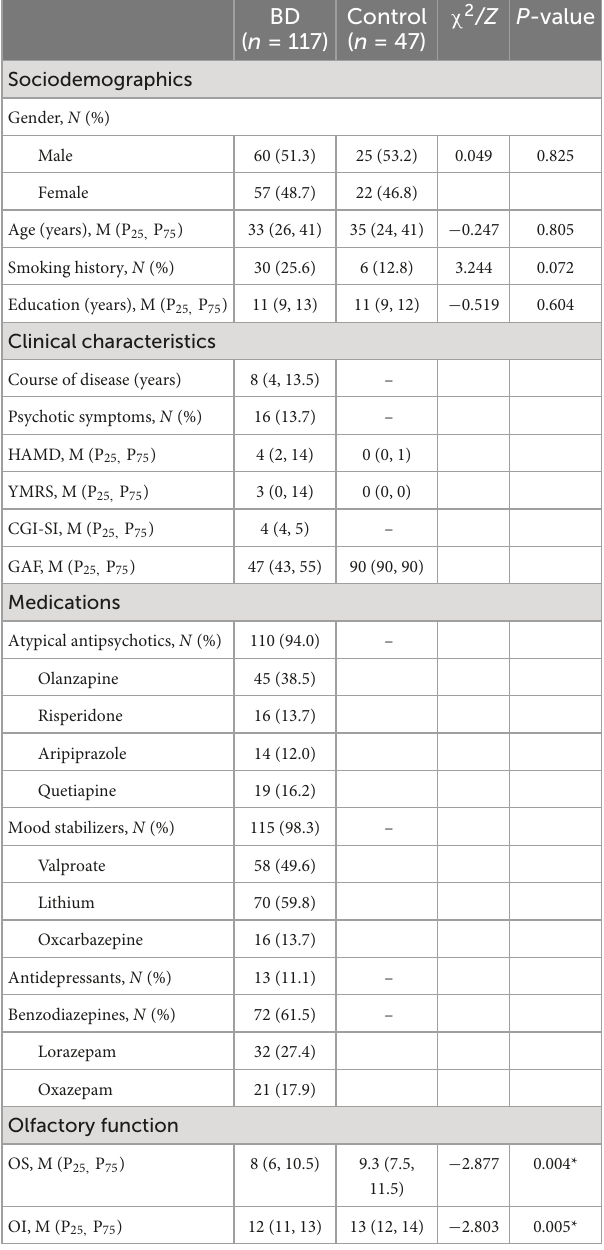
TABLE 1 Sociodemographic and clinical characteristics of the BD and control